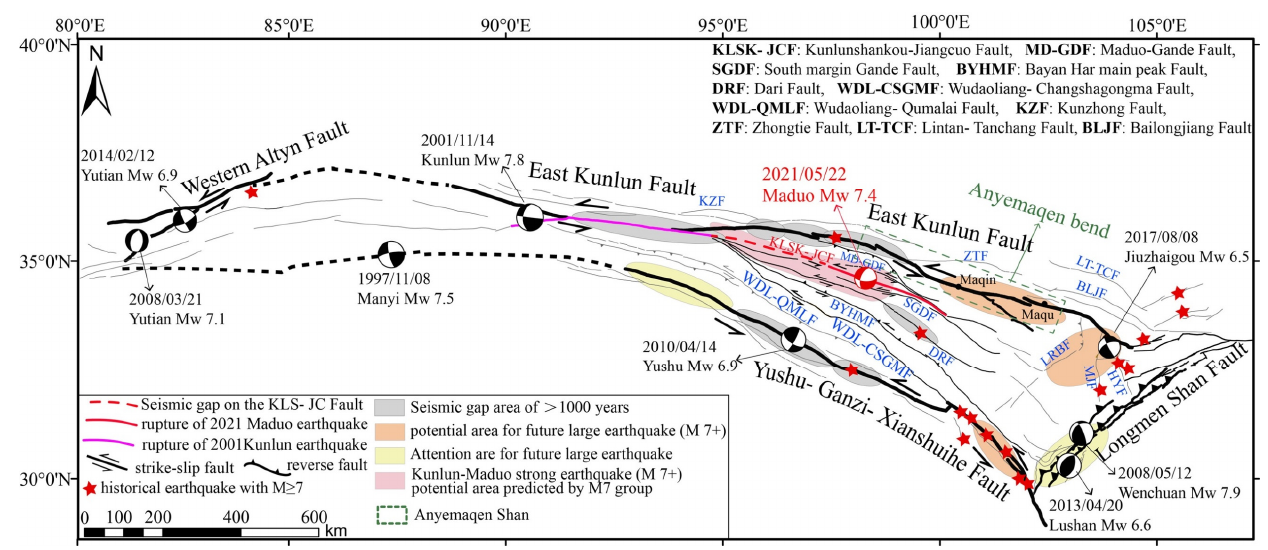
Figure 15. The boundary active faults and major large earthquakes as well as the evaluated potential areas of large earthquakes surrounding the Bayan Har Block, modified from (Working group of M7, 2012) [37] and (Pan et al., 2021) [38]. The pink line and red line indicate the rupture of the 2001 Mw 7.8 Kunlun earthquake and 2021 Mw 7.4 Maduo earthquake, respectively, while the dotted red line is a seismic gap without a rupture as of yet.